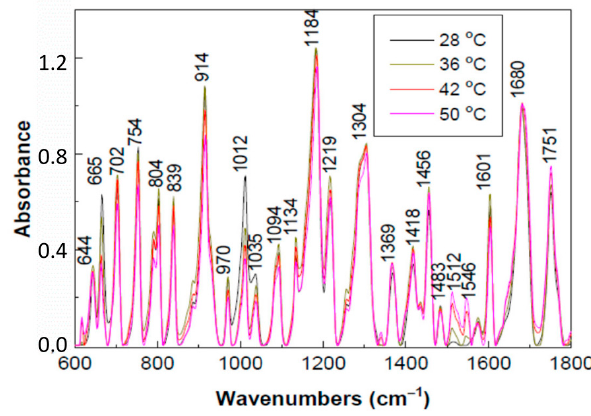
Figure 9. The dependence of the IR spectra of ASA with the temperature.